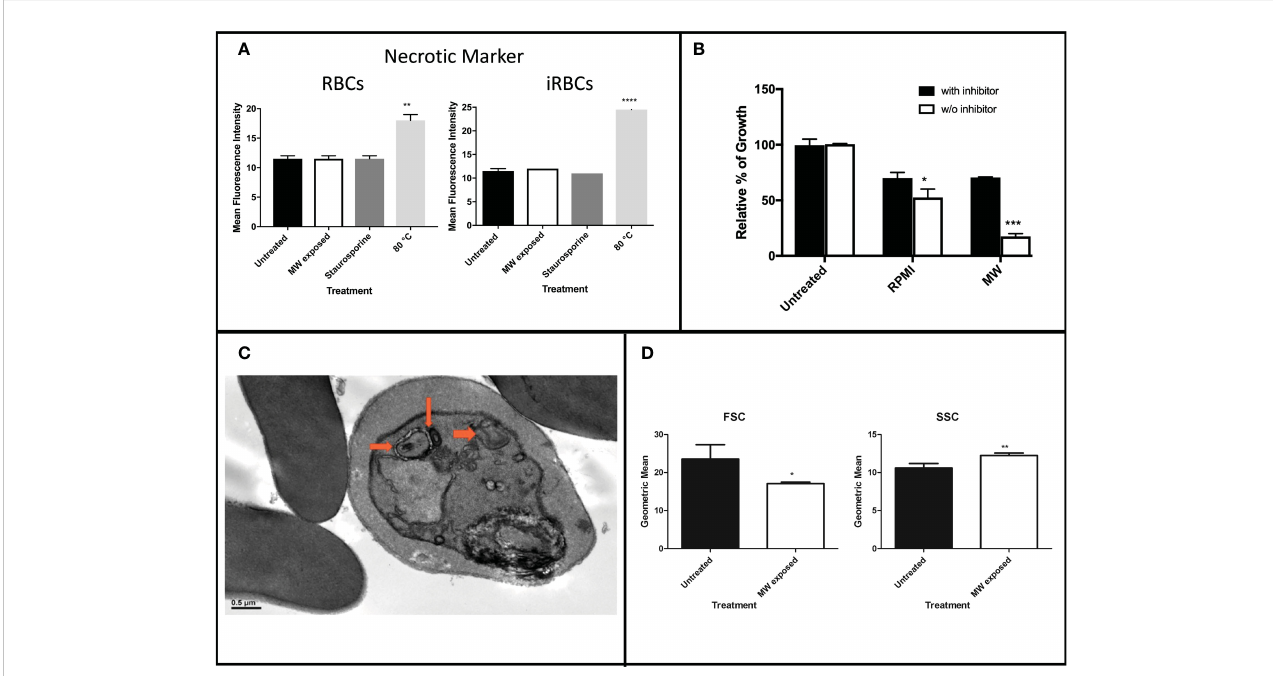
FIGURE 7 Assessment of necrosis or autophagy induced by MW exposure. (A) Levels of PI intake of uRBCs or iRBCs after MW treatment. Bars represent the mean relative fl uorescence intensities of two independent experiments ± SEM values read in a fl uorometer. One-way ANOVA analysis was used. (B) iRBCs were incubated with or without an autophagy inhibitor (3-MA) before exposing them to MW, or placed in starvation media as a positive control; n=3 ± SEM values; two-way ANOVA was used. Readings were obtained through fl ow cytometry. (C) Transmission electron microscopy (TEM) image of P. falciparum infected red blood cells six hours post microwave treatment. Arrows point to doubled-membrane autophagosomes. (D) Flow cytometry analysis of infected erythrocytes exposed to MW shows changes in size (FSC) and complexity (SSC). Data are the means of n=3 ± SEM. T-test analysis was used.